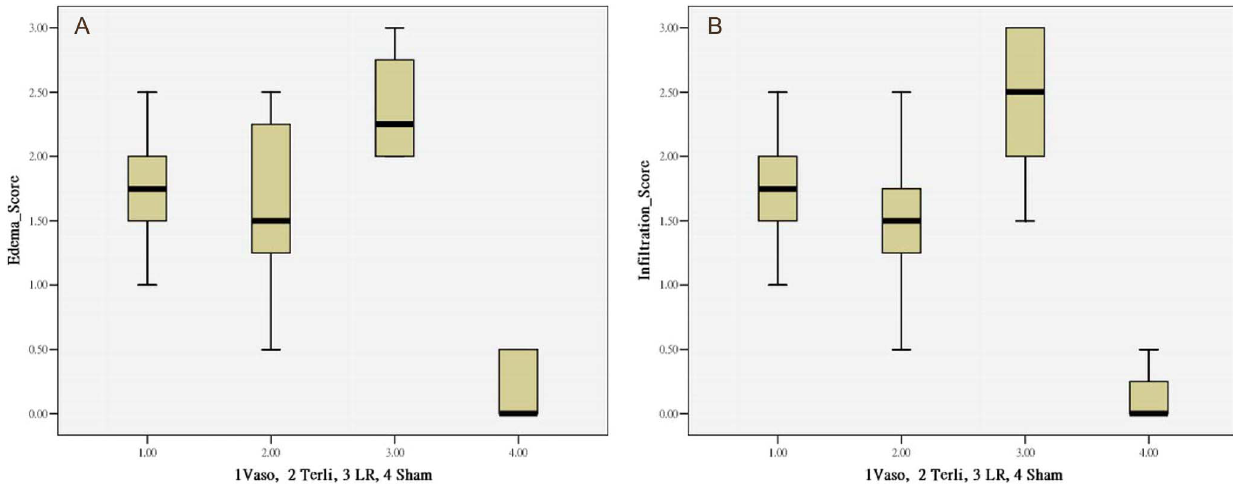
Figure 6. Histologic variables with regard to pulmonary edema formation and interstitial cell infiltration. A , Edema score, significant comparisons: Terli vs. LR (p=0.027) or Vaso vs. LR (p=0.01). B , Cell infiltration score, significant comparisons Terli vs. LR (p=0.020) or Vaso vs. LR (p=0.031). The Sham group showed significant lower pathologic scores than all other resuscitation groups ( P , 0.001 ).